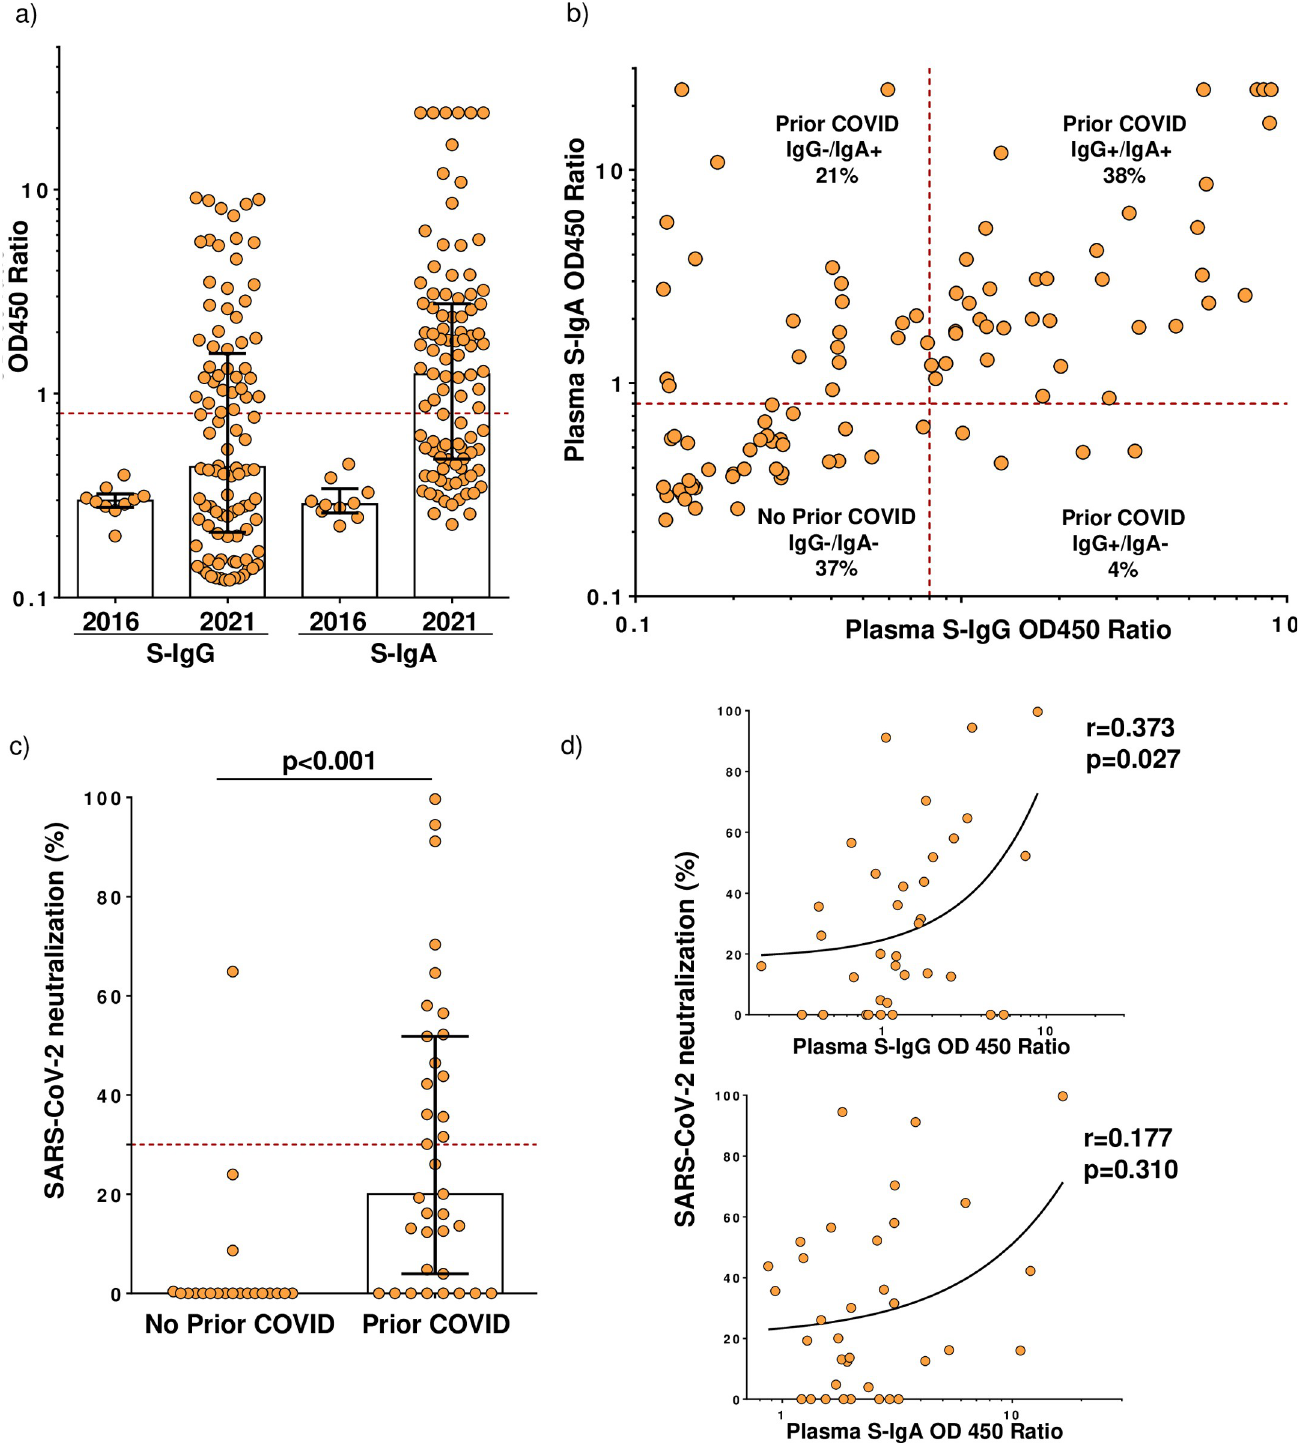
Fig 1. a) Distribution of optic density (OD) 450 ratios for blood SARS-CoV-2 Spike (S)-reactive IgG and IgA among the study participants recruited in Spring 2021 (n = 100) compared to the pre-pandemic samples obtained in 2016 (n = 10). b) Correlation plot of SARS-CoV-2 Spike-reactive IgG and IgA levels among the 2021 study participants (n = 98). In a) and b) the red dotted lines represent the assay cut-off values at OD450 ratios = 0.8 for positive samples for both IgG and IgA. c) The SARS-CoV-2 neutralization capacity of the 2021 study participant plasma samples measured using the surrogate virus neutralization test. N = 25 in the No Prior COVID group, and N = 30 in the Prior COVID group. The red dotted line represents the assay cut-off value at 30% for positive samples. d)